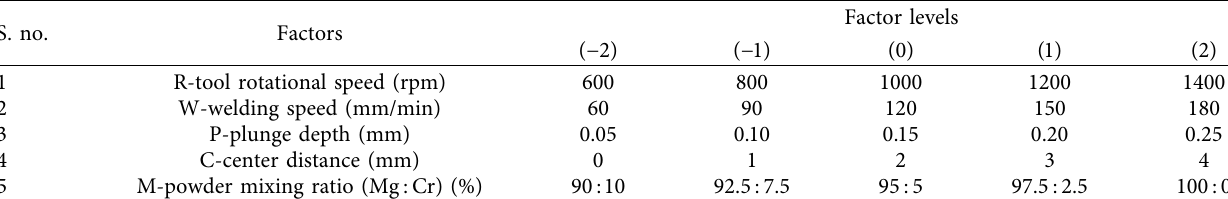
Table 4: Processing factors with their range and